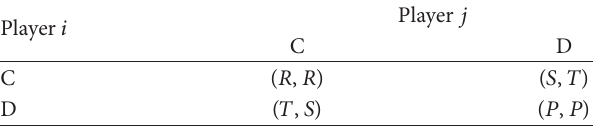
Table 1: Payoff matrix of prisoner’s